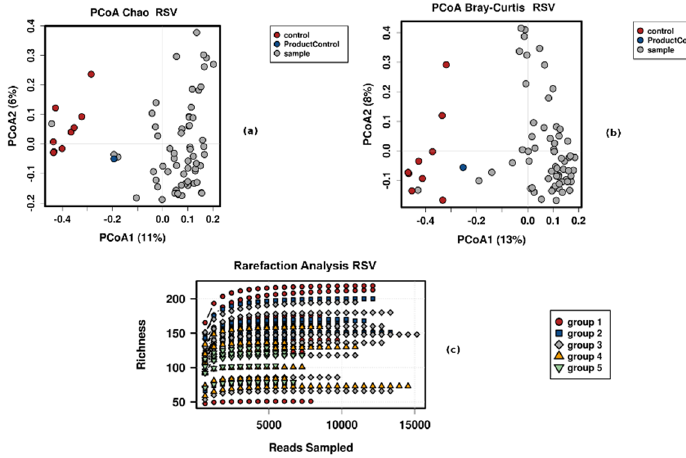
Figure A1. PCoA plots were created for ( a ) Chao and ( b ) Bray–Curtis for controls of the study compared with sample data from human participants. It shows that samples, product control, and controls are separate; ( c ) Rarefaction on RSV level, showing the sequencing potential of all samples based on age groups.